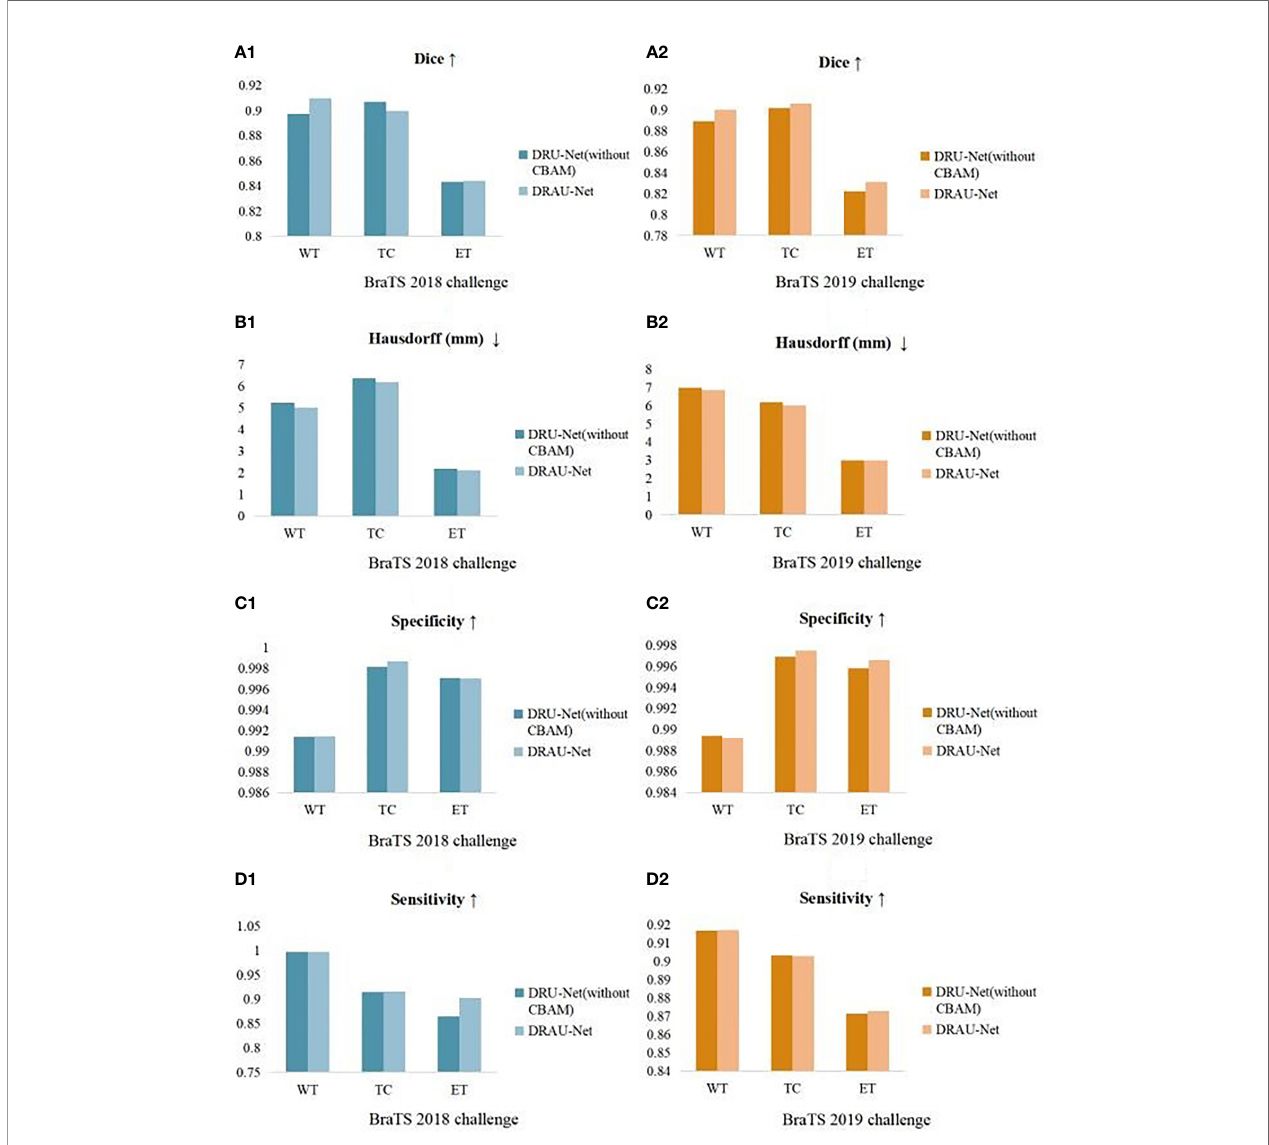
FIGURE 6 | Histograms of the considered evaluation metrics on the datasets of the BraTS 2018 and 2019 challenges. (A – D) : Dice, Hausdorff (mm), speci fi city, and sensitivity. Blue indicates the BraTS 2018 challenge dataset and orange indicates the BraTS 2019 challenge